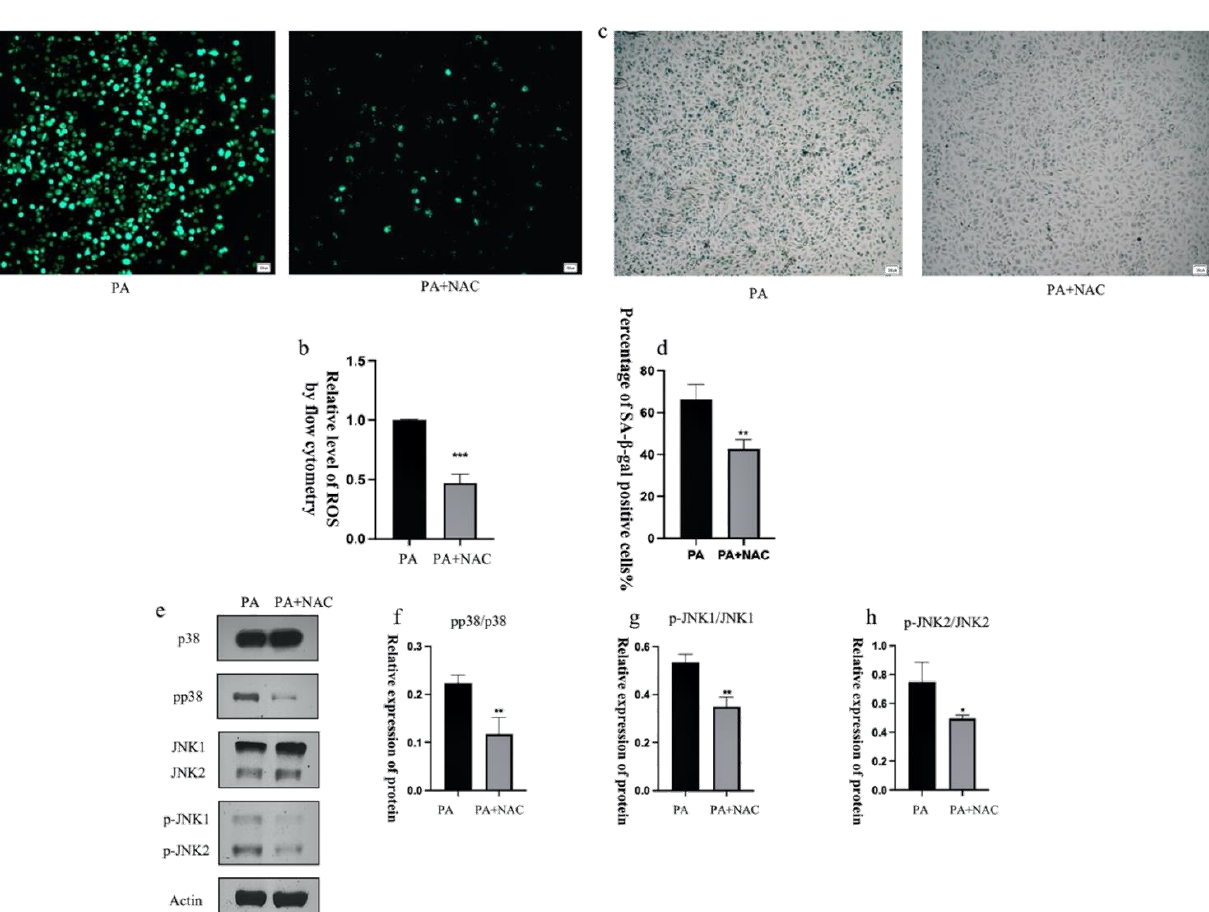
Figure 11. The ROS inhibitor NAC attenuated the activation of p38 and JNK proteins. ( a ) NAC (1 mM) decreased the elevated ROS levels induced by PA. ( b ) Results of ROS quantification using flow cytometry. ( c , d ) NAC (1 mM) decreased the number of β -galactosidase staining-positive cells. ( e – h ) NAC (1 mM) decreased p38 and JNK phosphorylation levels. Data are expressed as the means ± SD ( n = 3); * p < 0.05, ** p < 0.01, *** p < 0.001 vs. PA. All images are magnified to 100 ×